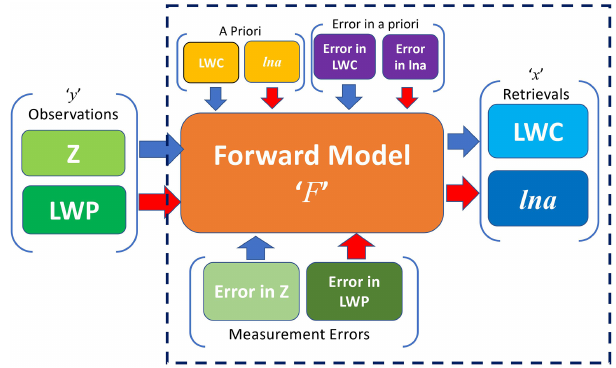
Figure 1. Schematic of LWC retrieval